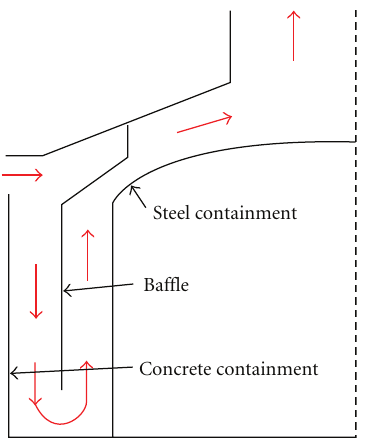
Figure 6: Containment model for lumped parameter analysis [ x ].